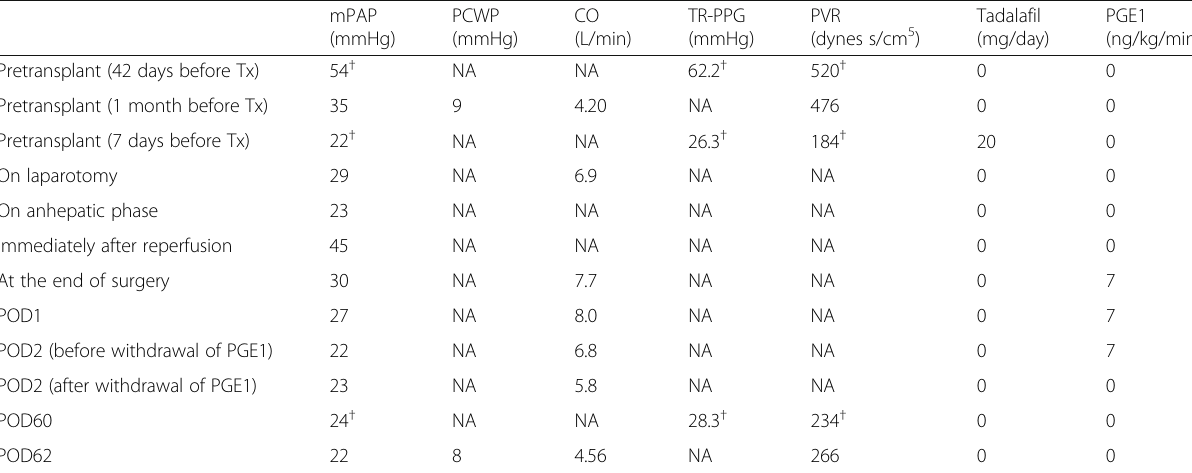
Table 1 Perioperative cardiopulmonary hemodynamics